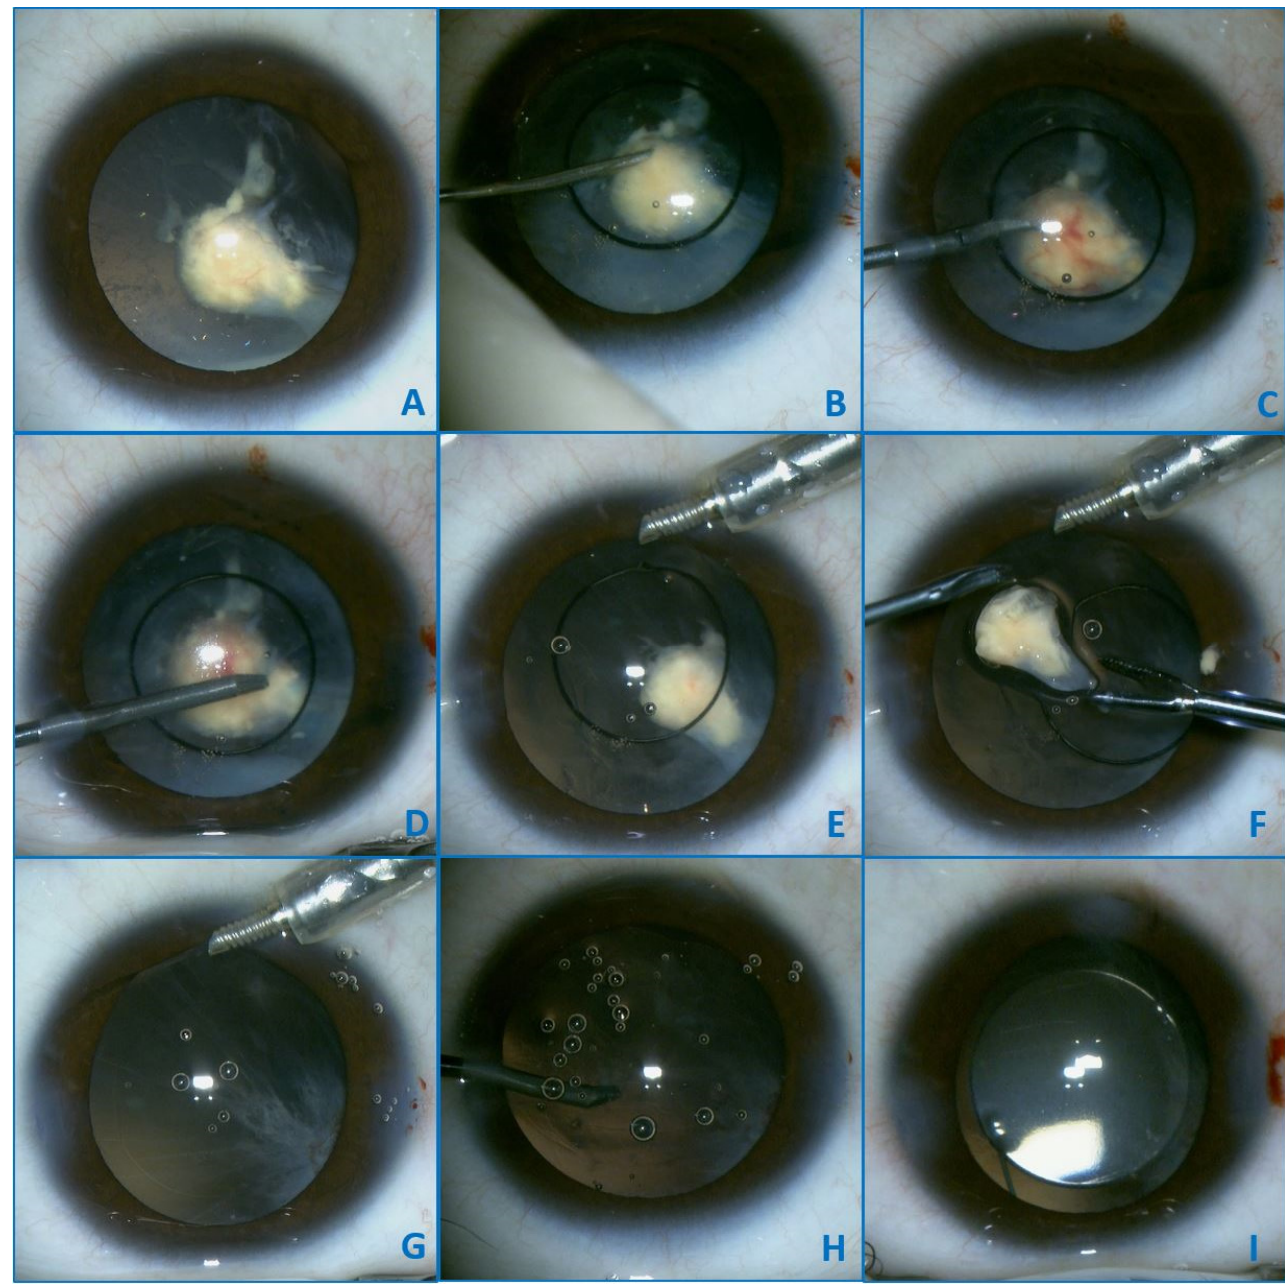
Figure 2. Intraoperative images—Initial aspect ( A ). During the surgery, the anterior capsule was firmly attached to the lens by fibrous adherences ( B – D ), which presented neovascularization, and a small amount of blood was discharged after manipulation ( C ). After aspiration of the lens material a vascular fibrotic tissue previously covered by the cortex and anterior capsule was discovered in the lens bag ( E ), with a greater consistency than the lens and a visible blood-vessel. The specimen was excised ( F ) and sent for histopathological examination. A fibrous vascularized proliferation remains attached in the supero-temporal region of the posterior capsule ( G ). A posterior capsulorhexis ( H ) with limited anterior vitrectomy and the excision of the fibrous proliferation were performed. The lens was implanted by using the technique of posterior optic capture, and the surgery was conducted without other complications ( I ).